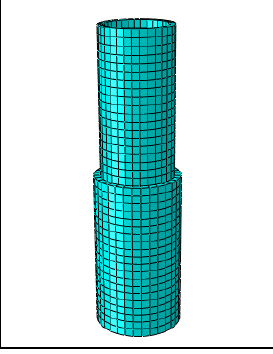
Figure 19. Model of a sleeve shear.